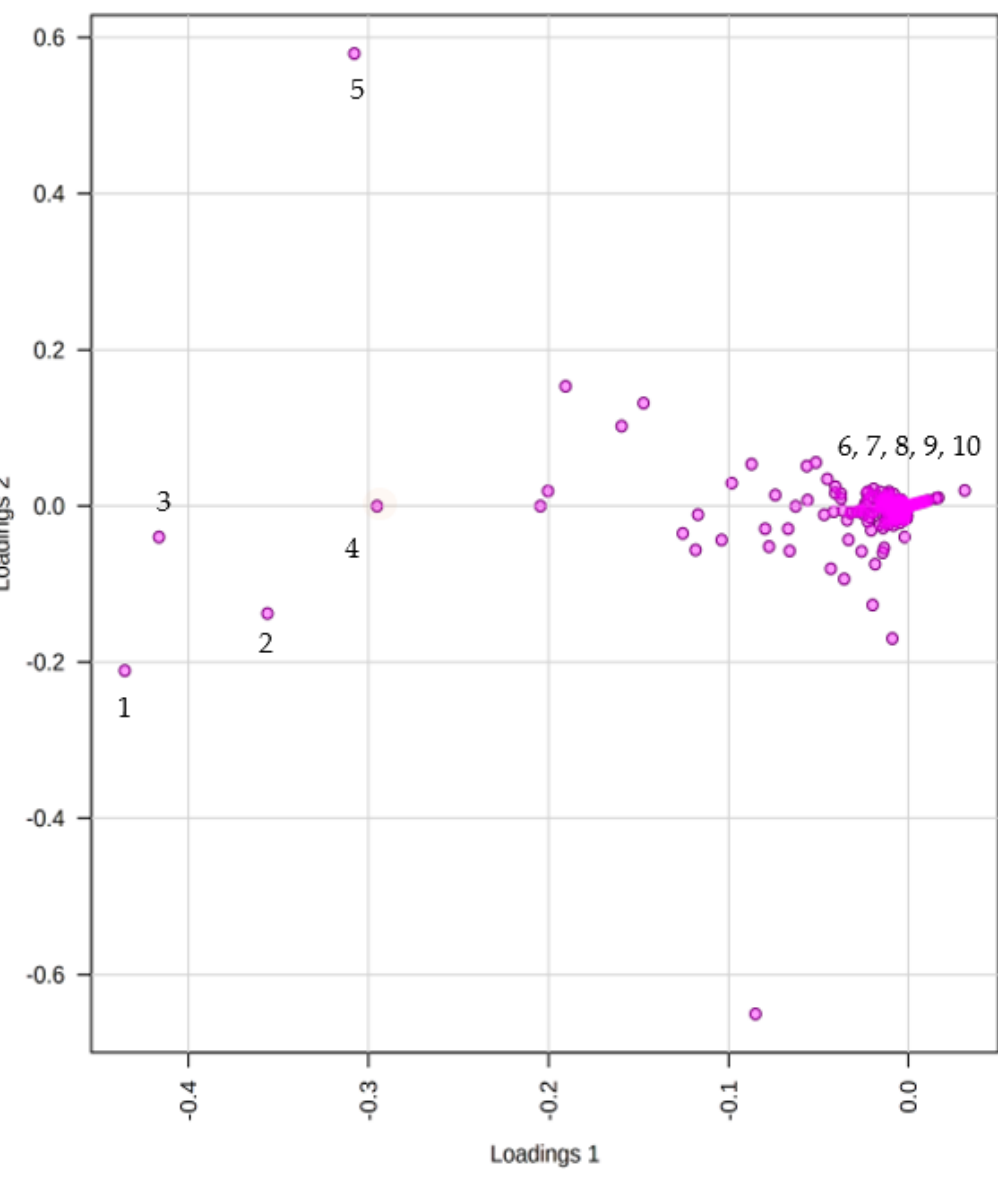
Figure 4. Principal Component Analysis (PCA) loadings score plot to display discriminant meta-bolites. Potential biomarkers were initially identified by their molecular weights and fragmen- tation patterns using mass spectrometry. The precise mass of each differential metabolite was searched using different databases (Reaxys, NPAtlas, PubChem) to confirm its identity, Table 1. Significant differential metabolites identified ( p -value < 0.05 VIP). possible molecular formula, and chemical composition (Table